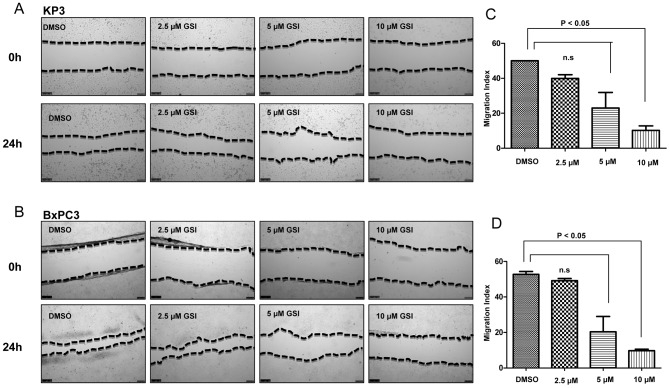
Notch plays a pivotal role for the regulation of migration in human pancreatic cancer cells.Treatment with GSI IX suppresses the migration potential of the human pancreatic cancer cell lines KP3 and BxPC3. Wound healing experiments of (A) KP3 and (B) BxPC3 cells cultured with GSI (2.5 µM, 5 µM, 10 µM) or control (DMSO). A scratch was made at (time 0 h) in both KP3 and BxPC3 and maintained for 24 h in conditioned medium with GSI or DMSO. The dotted lines are representing the edges of the wound. Photographs were taken under light microscope (10× magnification). After 24 h (A) Kp3 and (B) BxPC3 showed significant inhibition under 5 and 10 µM GSI treatment. In DMSO treated cells 80% to 90% of the wound healing was observed after 24 hrs. (C,D) The migration index was calculated as described in Material and Methods and plotted in bar graphs. P values were calculated with ANOVA analysis of variance along with Bonferroni post test. The error bar represents standard deviation. Differences were considered as statistically significant when the P-value was less <0.05 and non significant “n.s.” when the P-value was higher >0.05. The error bar represents standard deviation.